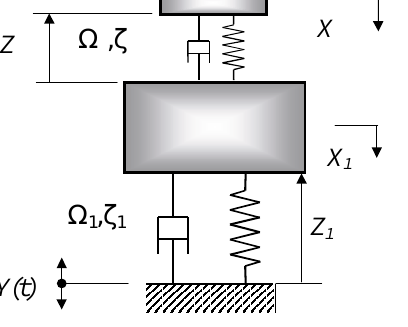
Fig. 9. Model of vibration protection